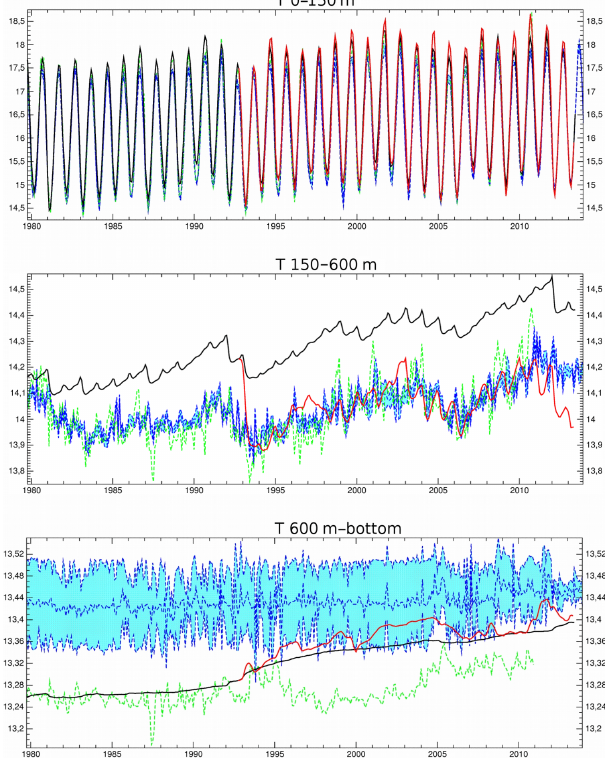
Figure 8. Evolution of the monthly integrated heat content (ex- pressed as mean temperature in ◦ C) over the Mediterranean basin for the layers 0–150m (top), 150–600m (middle) and 600m- bottom (bottom) from MEDRYS (red line), NM12-FREE (black line), EN3 (dotted green line) and the IMEDEA (blue dotted line) hydrographic gridded products. The blue shaded area indicates the uncertainty ranges around the values of